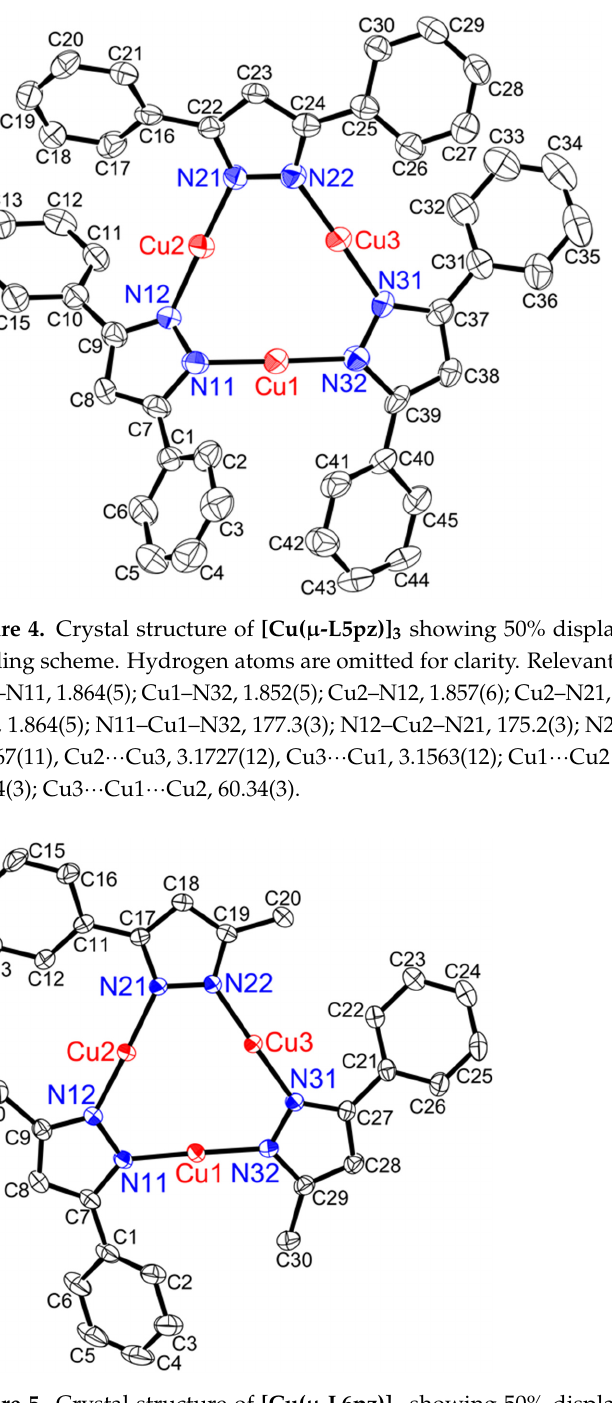
Figure 5. Crystal structure of [Cu( µ -L6pz)] 3 showing 50% displacement ellipsoids and the atom labeling scheme. Two crystallographically independent molecules are present, whose structural features are essentially identical. Molecule 1 is presented here. Hydrogen atoms are omitted for